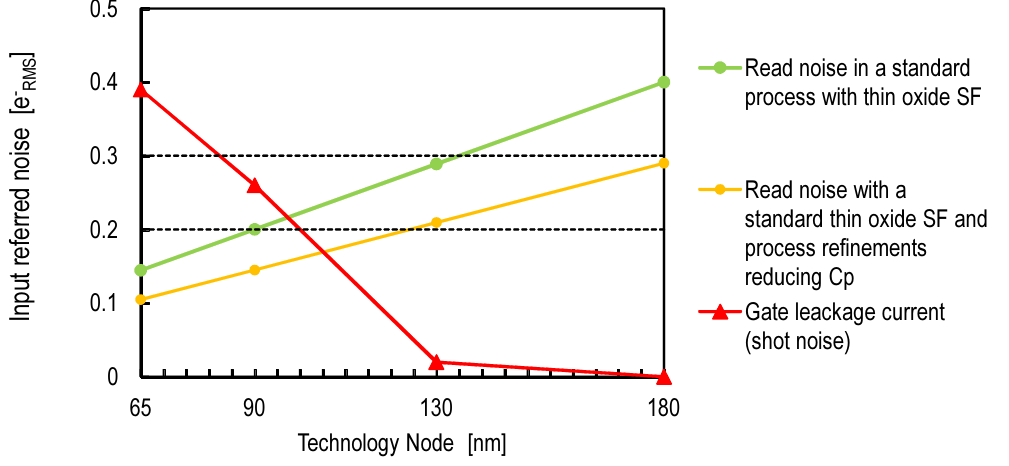
Figure 16. The expected evolution, with technology downscale, of the input-referred 1/ f noise of CIS designed with standard CMOS process with thin oxide in-pixel